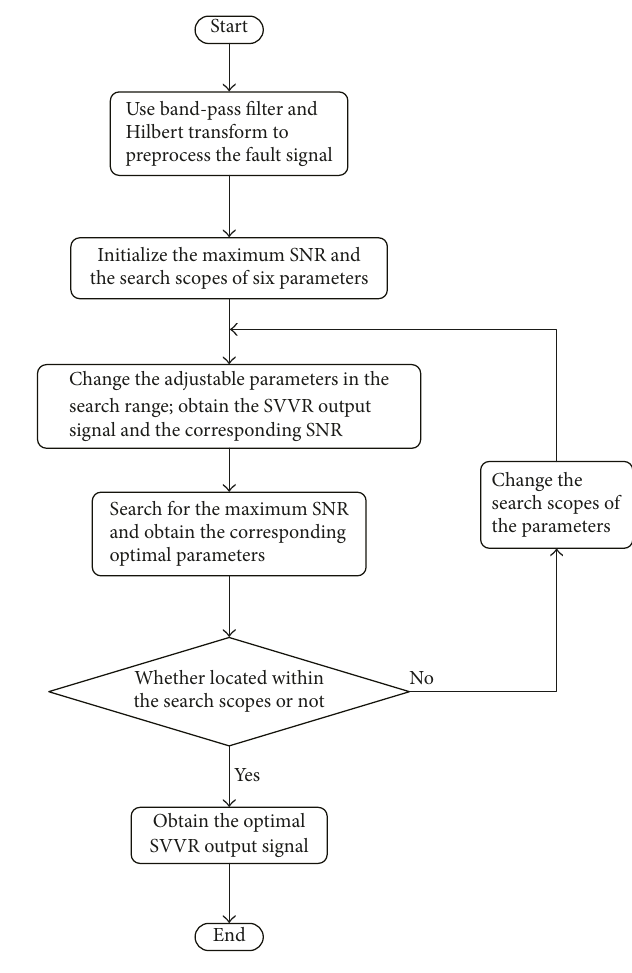
Figure 3: The algorithm flow